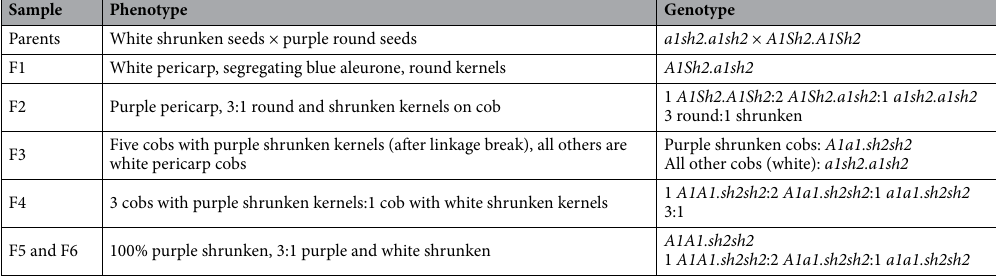
Table 1. Expected phenotypes and genotypes of each experiment.